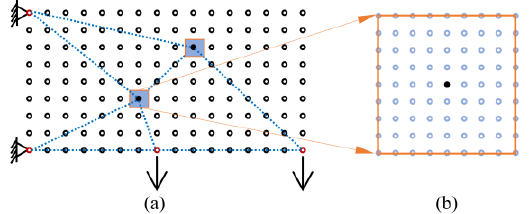
Figure 3. Uniform discretization policy for continuous space in AlphaTruss. ( a ) 17 × 9 grid pattern for stage I. ( b ) 9 × 9 grid pattern for stage II for one candidate